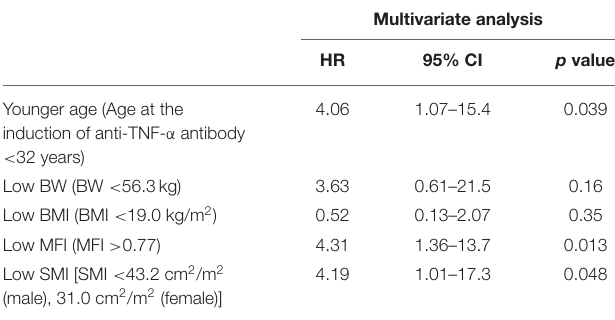
TABLE 3A | Univariate analysis of factors associated with bowel resection during anti-TNF therapy (log rank test).